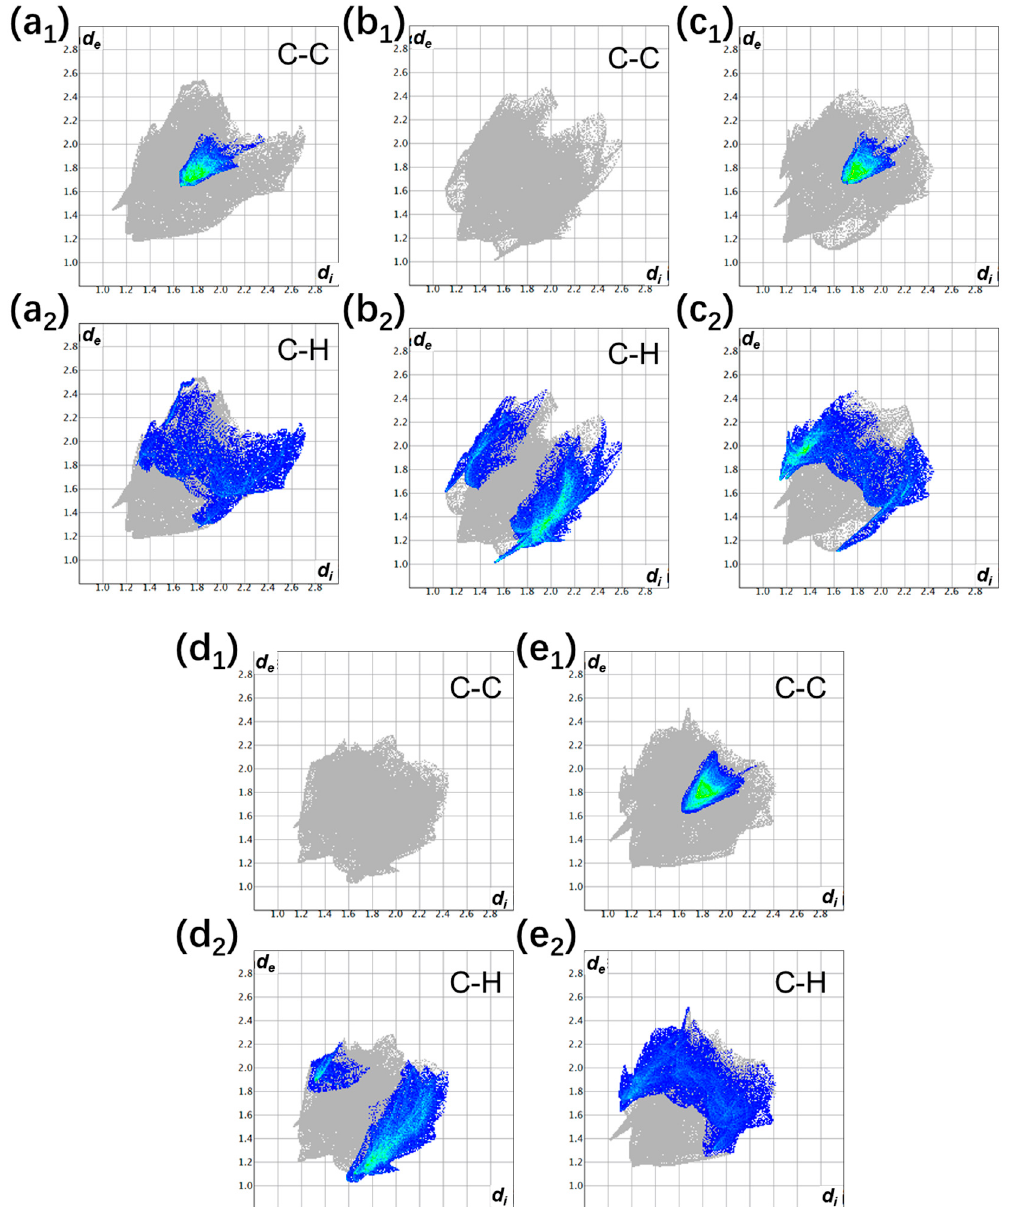
Figure 10. Fingerprint plots visualizing d e and d i for C···C, C···H, C–H···N contacts (including reciprocal ones) generated for TCNQ in P1T1 ( a 1 , a 2 , a 3 ), P2T1 ( b 1 , b 2 , b 3 ), and P3T1 ( c 1 , c 2 , c 3 ).